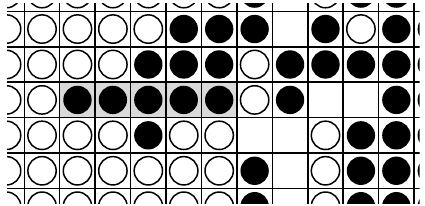
Figure 80. WHITE